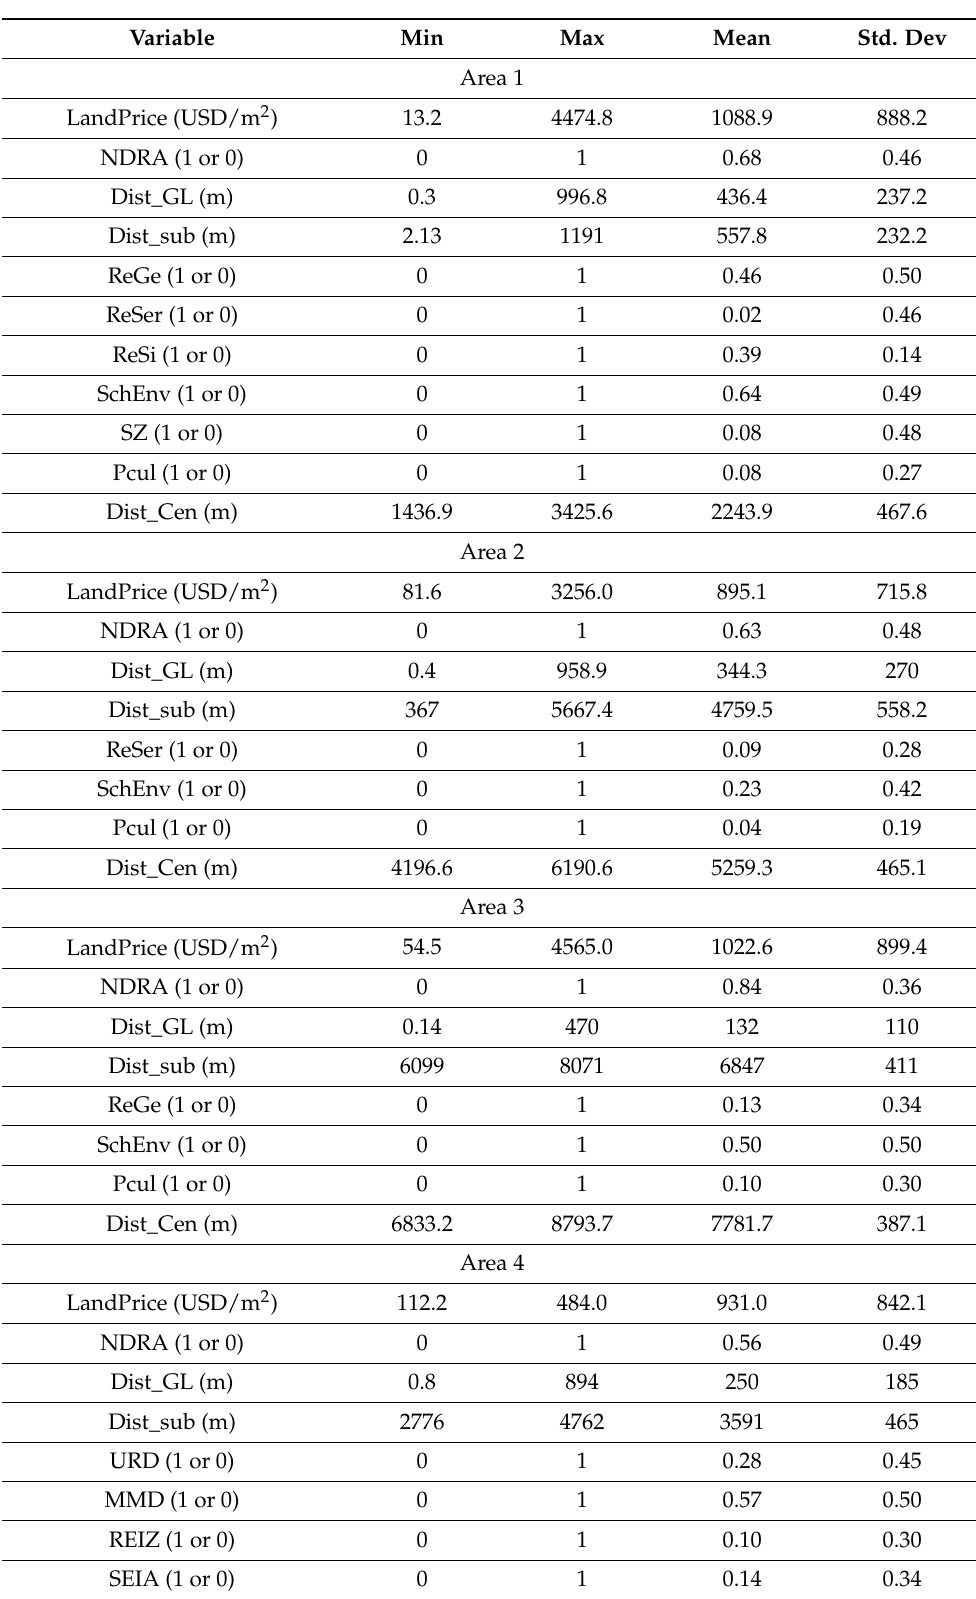
Table 1. Descriptive statistics for each area (within 1000 m radius from the center of the